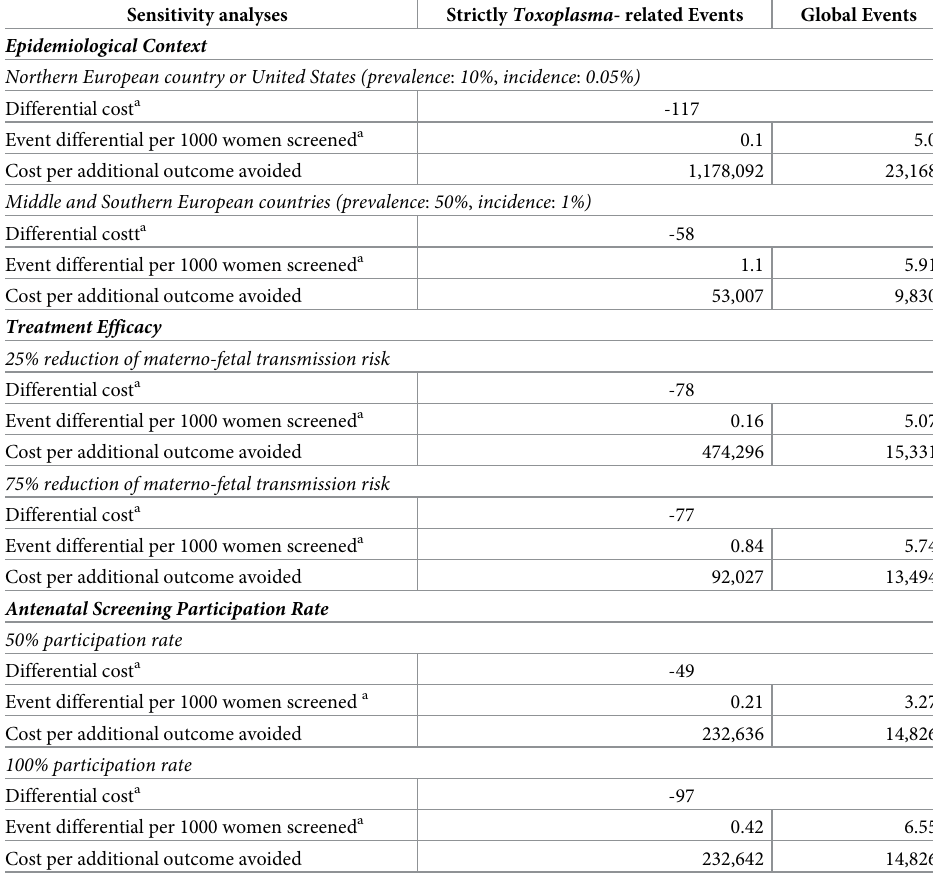
Table 4. Sensitivity analyses: Short term assessment (Toxoscreen